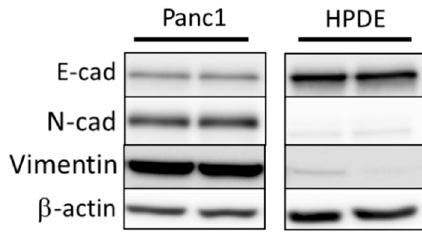
Figure 1. Immunoblotting of basal levels of EMT markers E-cadherin (E-cad), N-cadherin (N-cad), and vimentin in Panc1 and HPDE cells. β -actin was used as loading control.